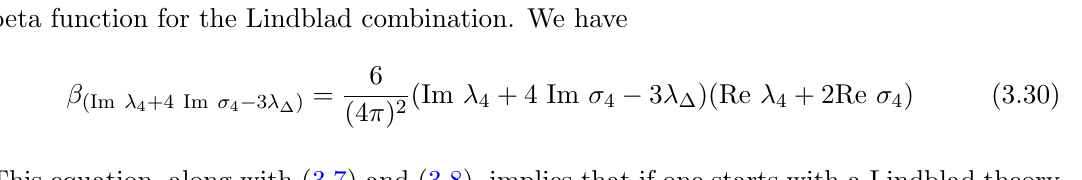
Figure 16. Diagrammatic representation of the Ten 1-Loop Integrals (cid:30) R (cid:30) R k 1 + k 4